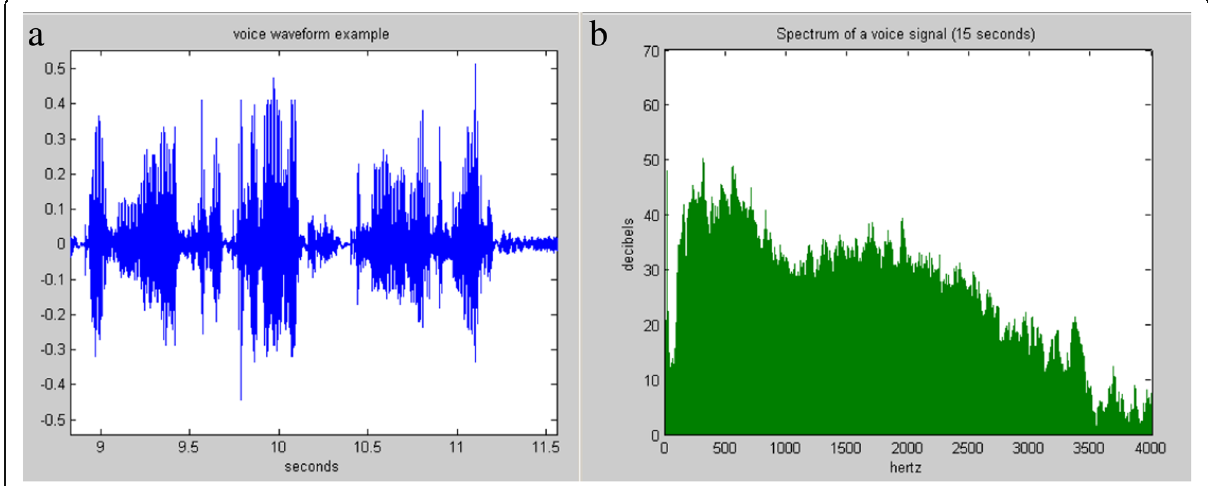
Fig. 3 An acoustic audio number (left) and its corresponding spectrum